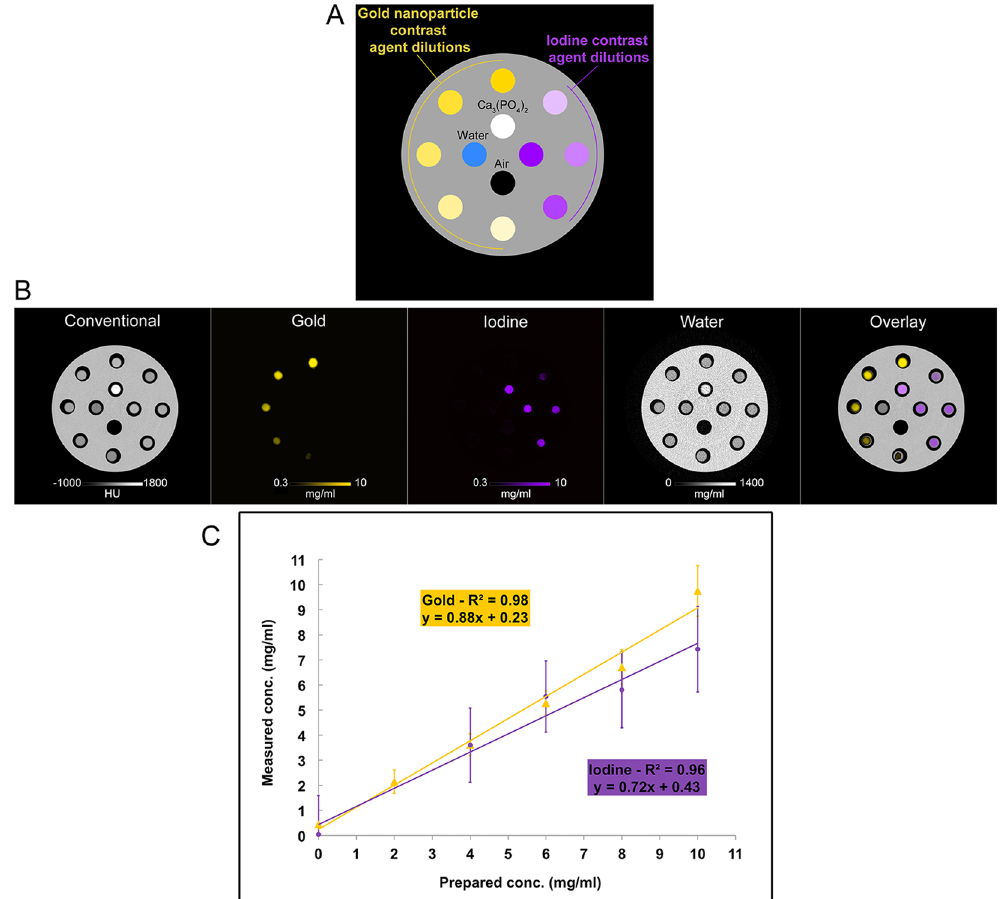
Figure 3. ( A ) Schematic of the phantom with unmixed solutions. ( B ) Conventional, gold, iodine, water and overlay images are depicted. ( C ) Graph of the expected and the measured